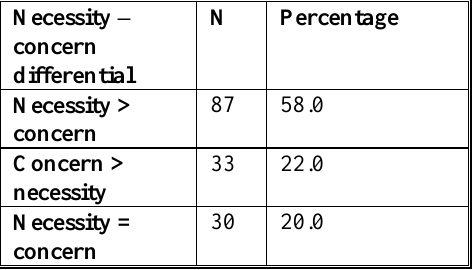
Table 5. BMQ necessity-concern differential